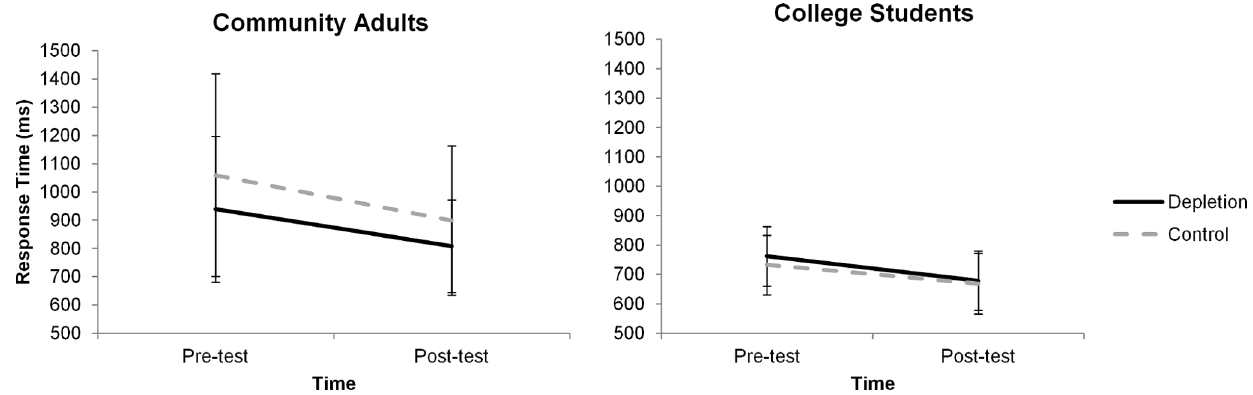
Figure 2. Mean ( ± SE) response time (in milliseconds) for Stroop responses at pre-test and post-test in community adults and young adults, by condition. (Depletion = solid line, Control = dashed line).